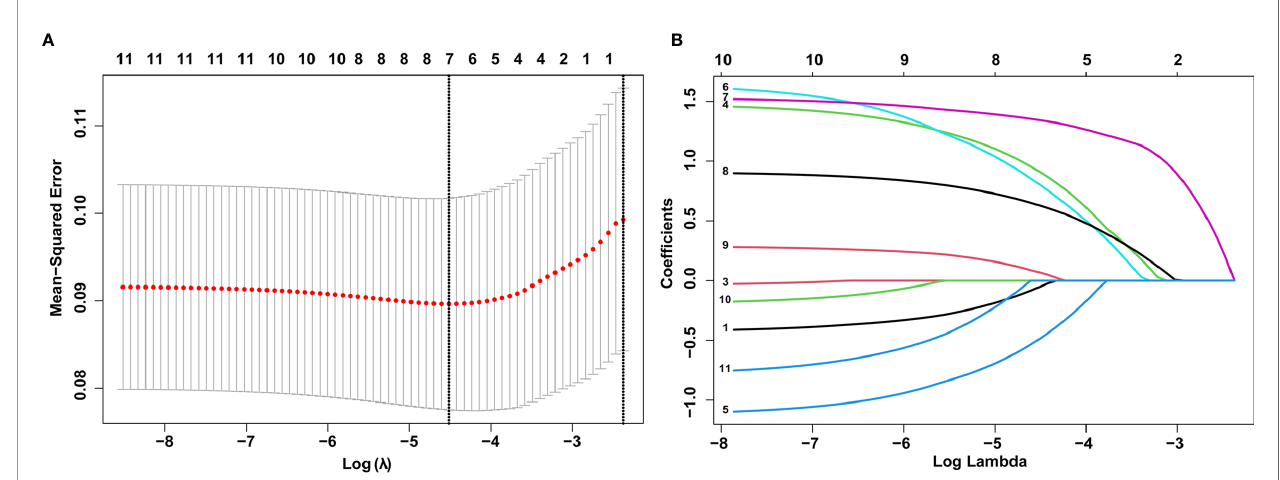
FIGURE 2 | Selection of demographic and clinical features using the least absolute shrinkage and selection operator (LASSO) regression model. (A) Selection of optimal parameters (lambda) from the LASSO model using 10-fold cross-validation and minimum criteria. Dotted vertical lines were drawn at the optimal values using the minimum criteria and the 1 standard error of the minimum criteria (1-SE criteria). (B) LASSO coef fi cient pro fi les of 10 features. A coef fi cient pro fi le plot was produced against the log (lambda) sequence.